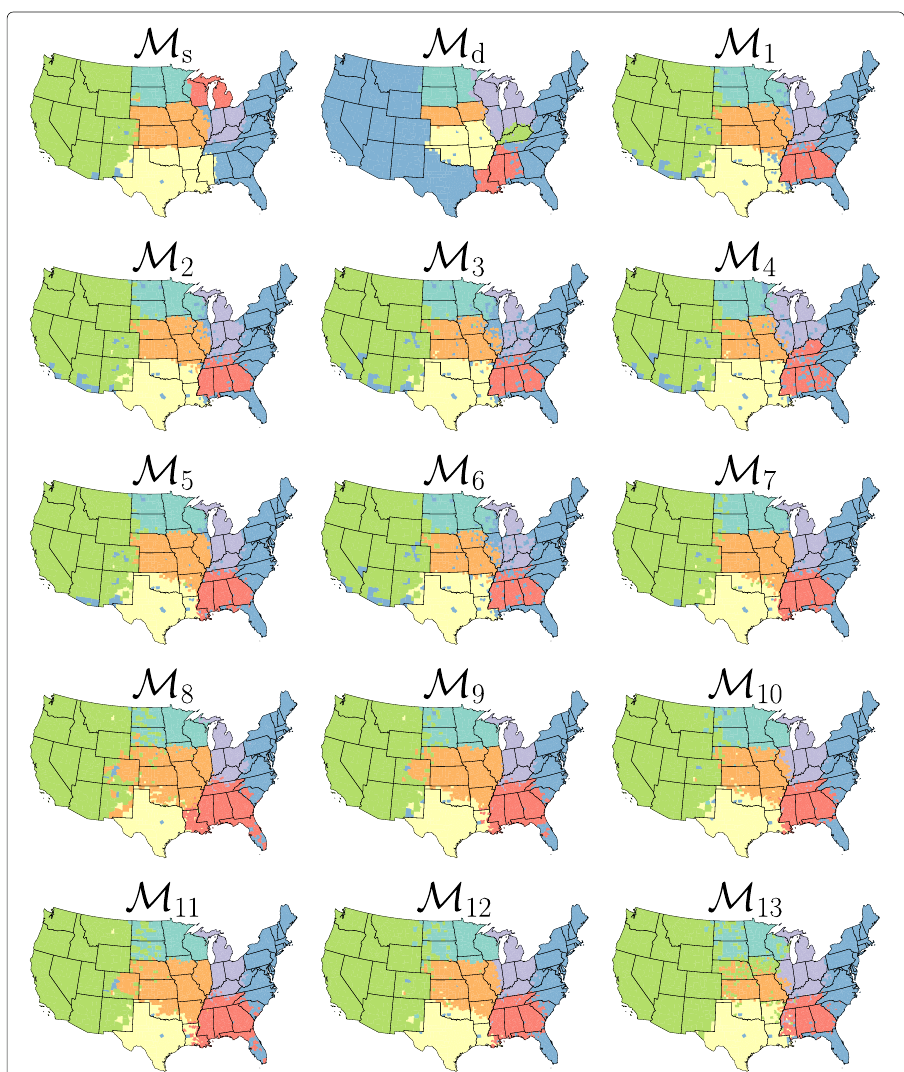
Fig. 19 Weighted functional motif-based clusterings of the US-M IGRATION network, for all motifs on at most three nodes. Each county (node) is colored by its cluster allocation